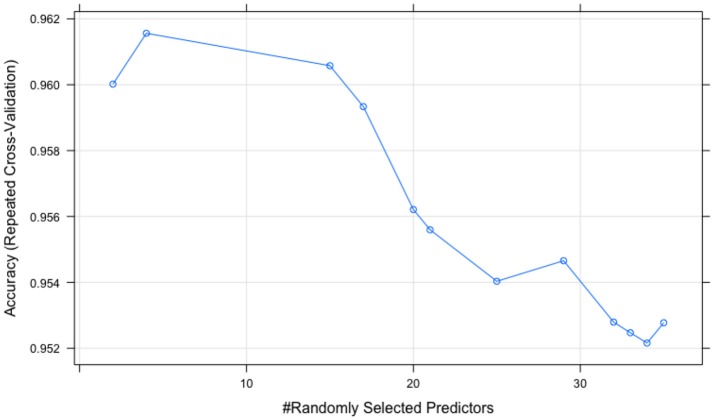
The random forest tuning results (peak point corresponds to mtry = 4).